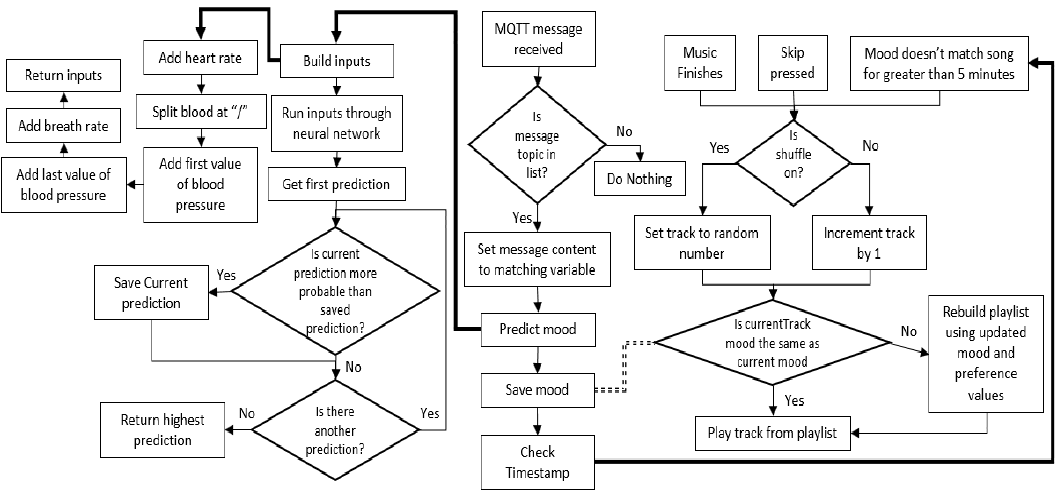
Figure 6. Flow diagram illustrating the integration of ANN, MQTT and media